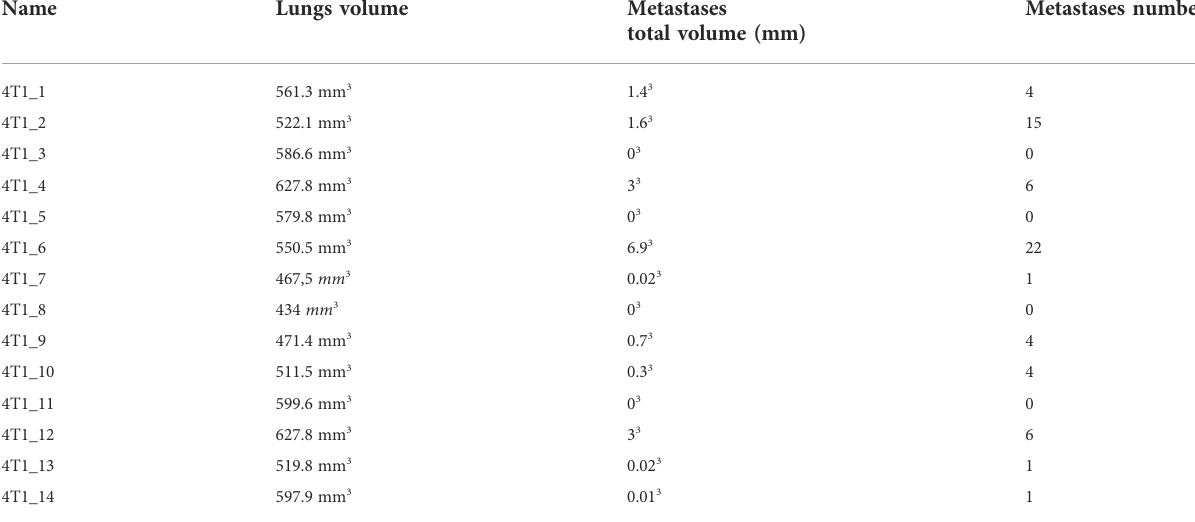
TABLE 4 Results of DeepMeta ’ s prediction on mice bearing 4T1 lung